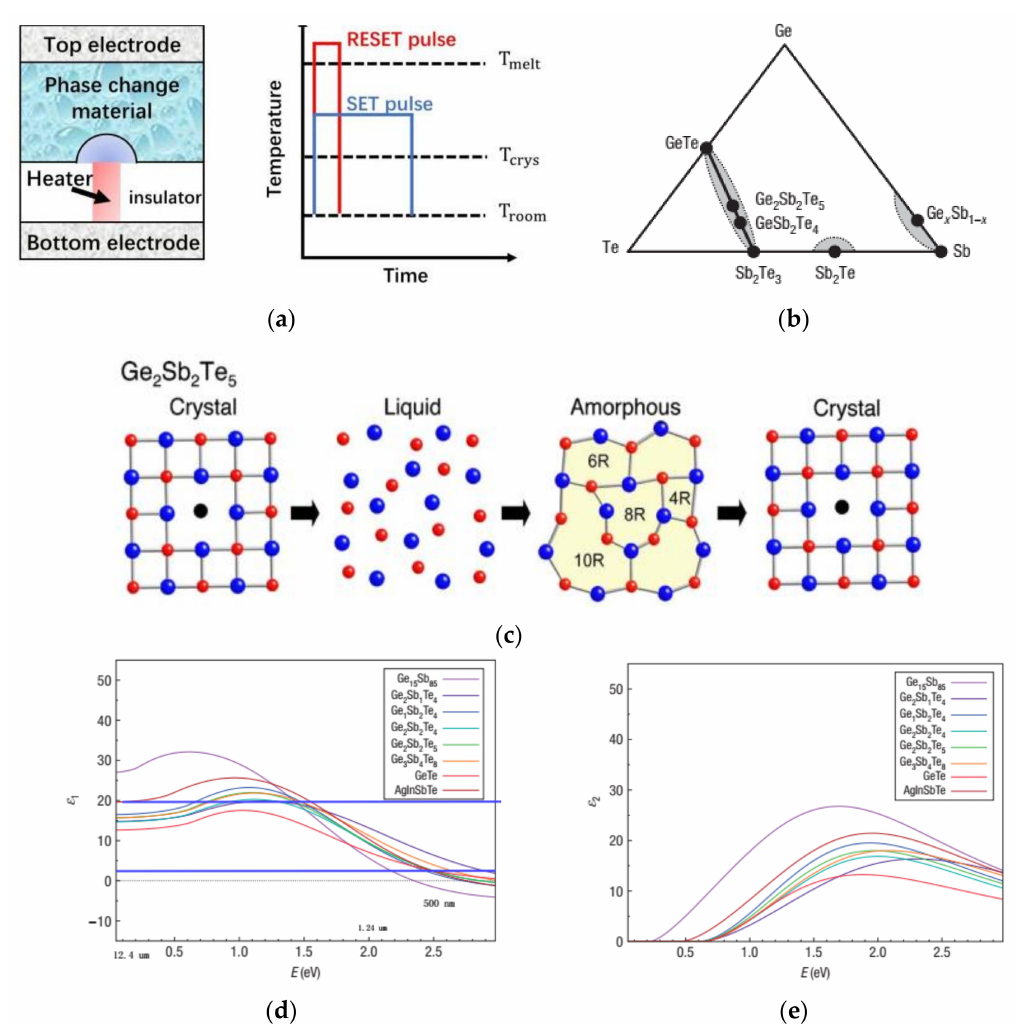
Figure 1. The schematic of phase transition in chalcogenide phase change materials (PCMs); ( a ) a typical cell of phase change memory and the curve of phase transitions triggered by electrical pulses, reproduced with permission from; ( b ) the phases diagram of germanium (Ge) antimony (Sb) telluride (Te) alloy (GST) with varied ternary compositions. The often-used GST can be found along the pseudobinary route between GT and S 2 T 3 , reproduced with permission from [88]; ( c ) an artistic impression of typical phase transition process of G 2 S 2 T 5 , reproduced with permission from [105]; ( d , e ) the optical constants of commonly used GSTs, both reproduced with permission from